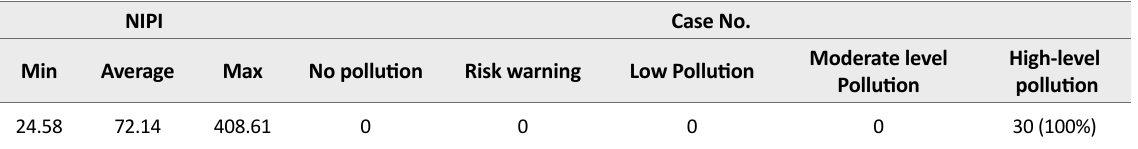
Table 8. Descriptive statistics of Nemerow Integrated Pollution Index (NIPI) at stations under study